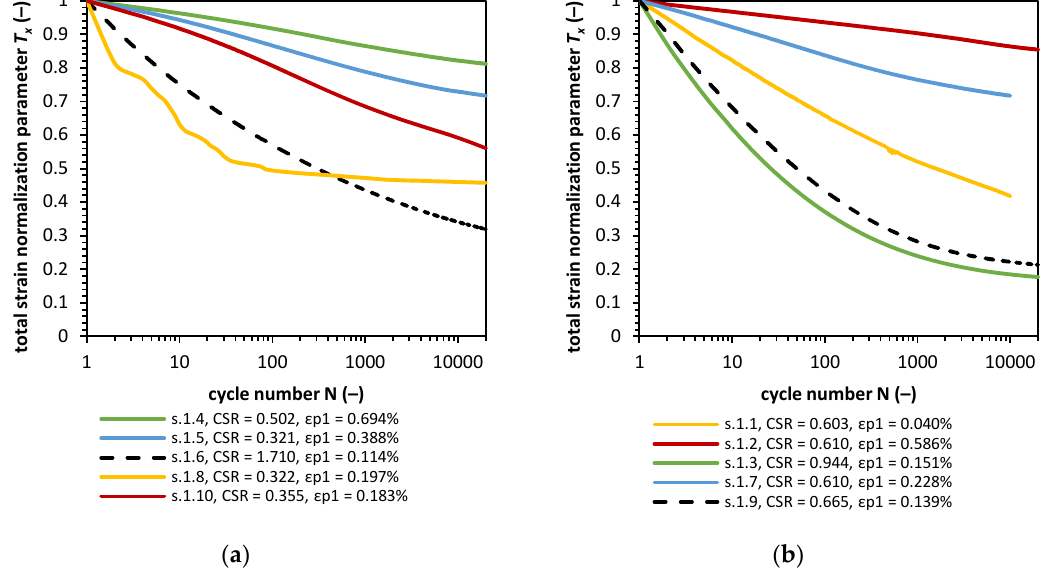
Figure 9. Total strain normalization parameter in confining pressure equal to 18, 90 and 135 kPa ( a ), and for the samples consolidated with confining pressure at around 45 kPa ( b ).